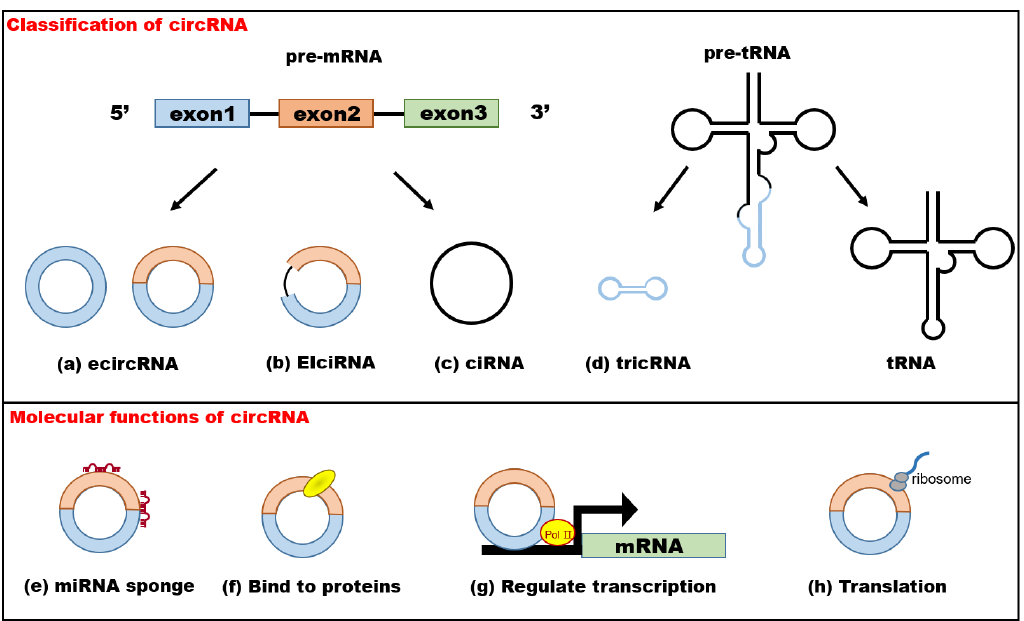
Figure 1. Classification and molecular functions of circRNAs. The top of the figure shows that circRNAs are divided into 4 categories: ( a ) exonic circRNAs (ecircRNAs), ( b ) exon–intron circRNAs (EIciRNAs), ( c ) intronic circRNAs (ciRNAs), and ( d ) tRNA intronic circular RNAs (tricRNAs). The bottom of the figure shows four potential functions of circRNAs: ( e ) microRNA (miRNA) sponging: some circRNAs serve as efficient miRNA sponges, regulating the activity of miRNA target genes; ( f ) binding to proteins: circRNAs affect protein function directly; ( g , h ) regulation: some circRNAs regulate transcription and encode peptides or proteins if they have internal ribosome entry sites (IRESs).